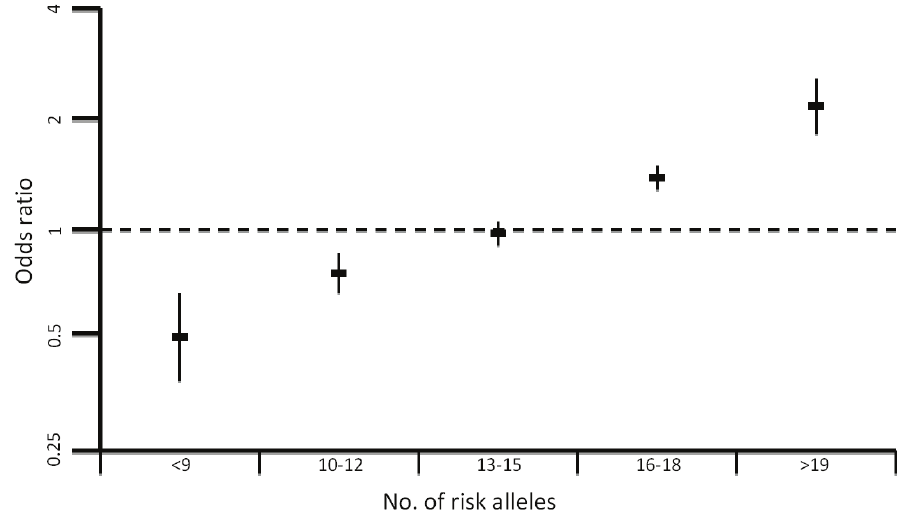
Figure 2. Plot showing the increase in odds ratio for colorectal cancer with an increasing number of risk